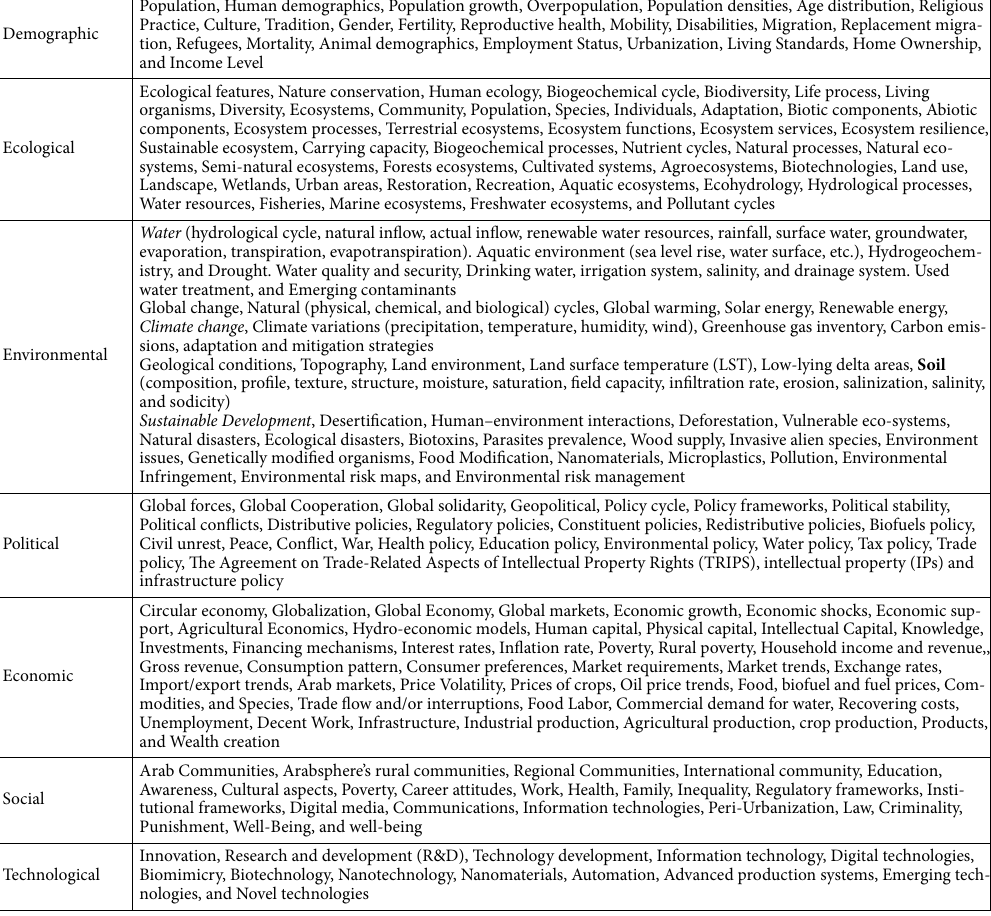
Table 4. DEEPEST holistic framework of macro-future